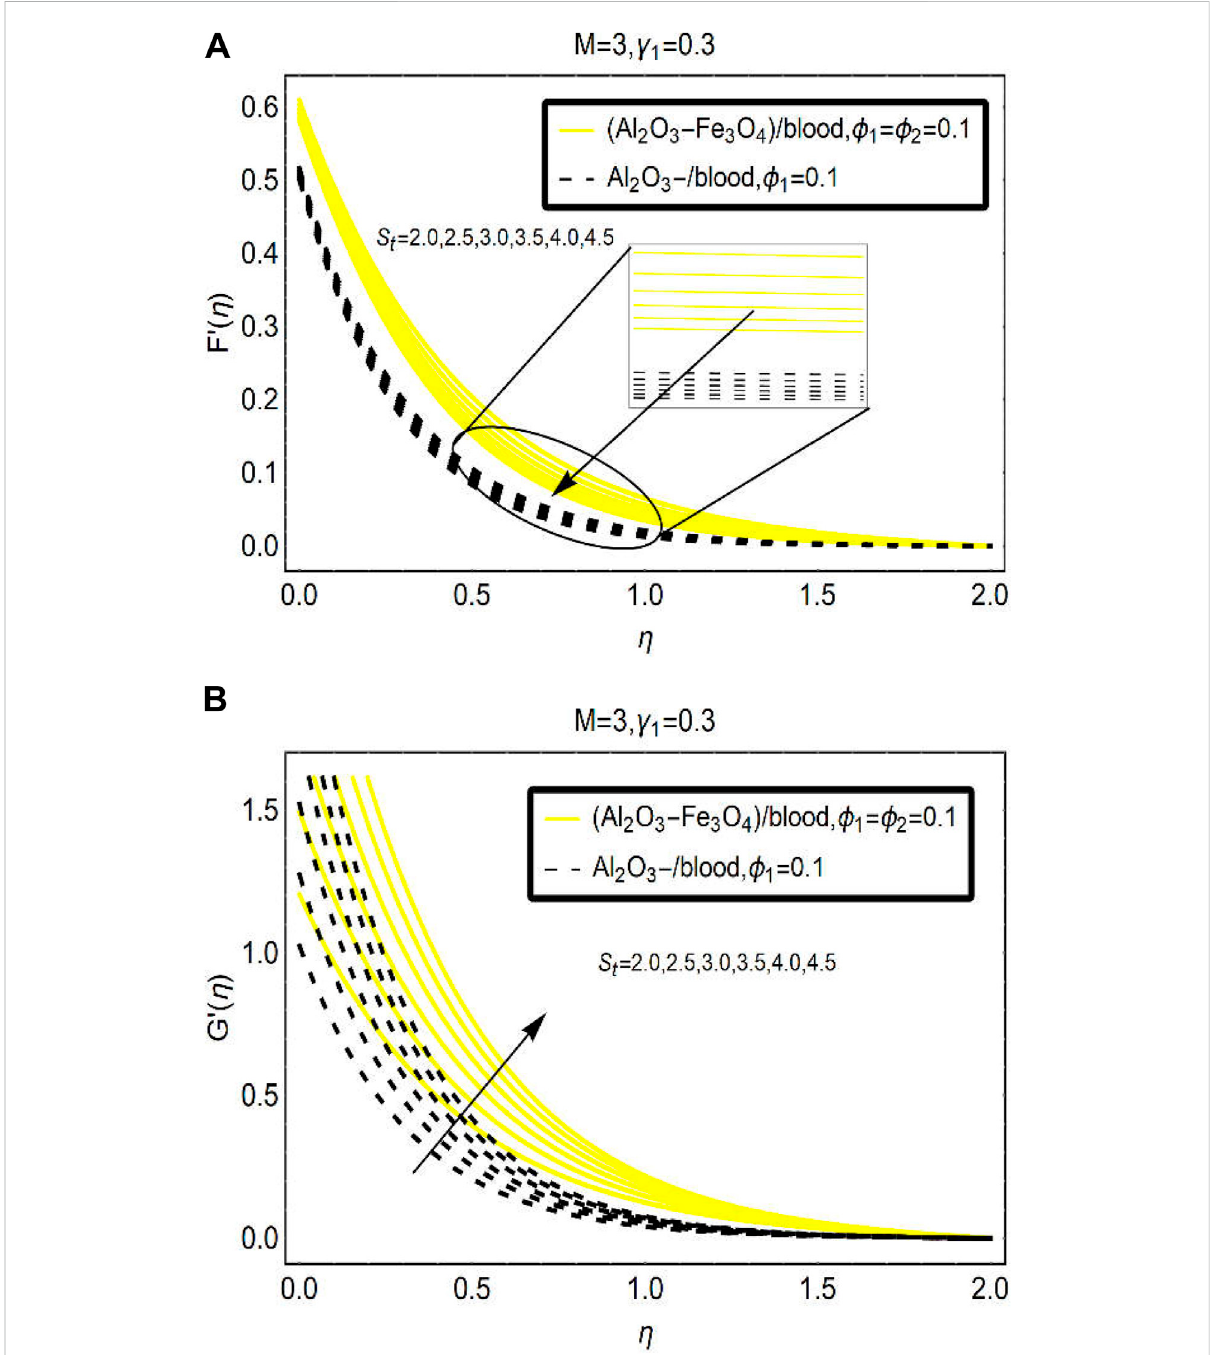
The velocity changes under varying S t (stretching parameter) for (A) F ′ and (B) G ′